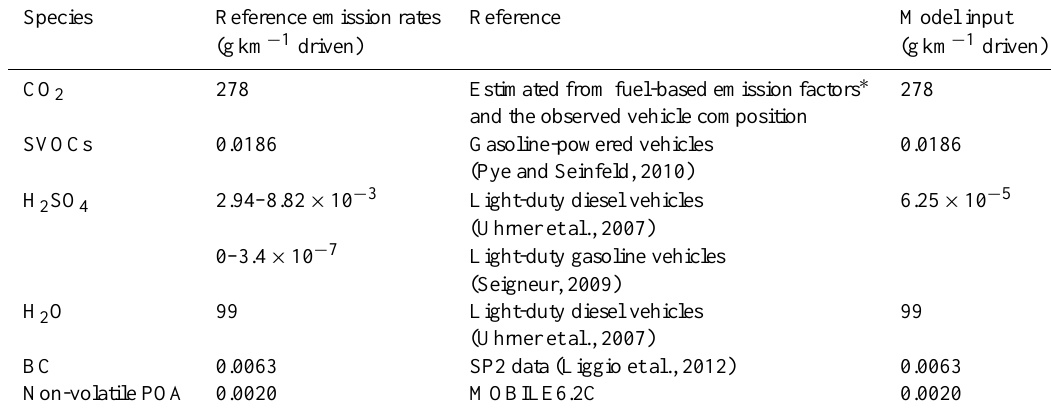
Table 4. Tailpipe gaseous and particulate species mass emission rates (gkm − 1 driven) for gasoline engines.